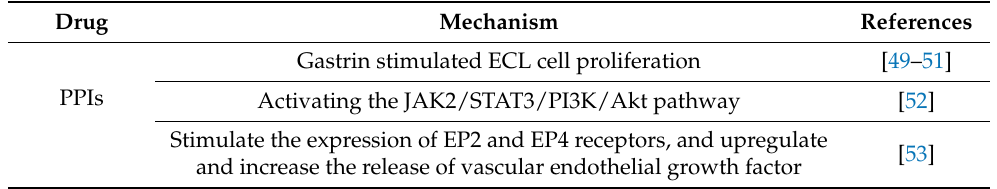
Table 3. Summary of biological studies that investigated the association between PPIs and gastric